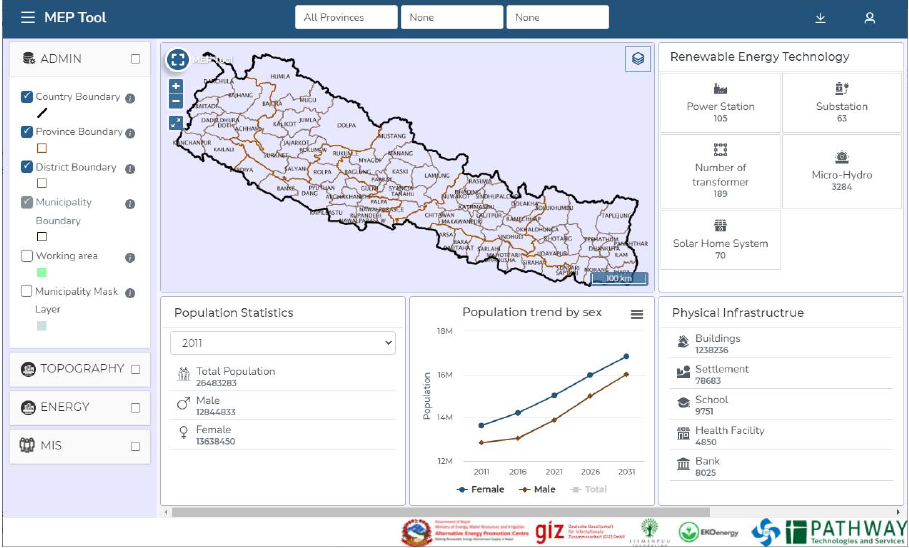
Figure 2. Dashboard mode of Municipal Energy Planning Toolkit.